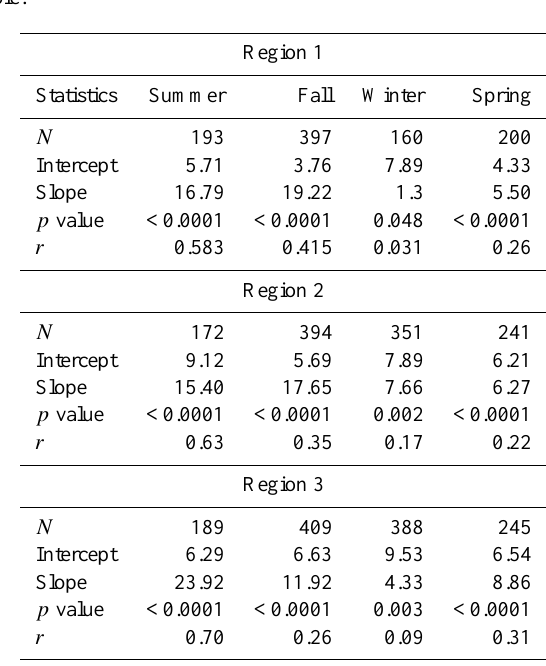
Table 3. Seasonal statistics of correlation between fine-resolution MAIAC 1km AOD and PM 2 . 5 for days that MYD04 was unavail- able.